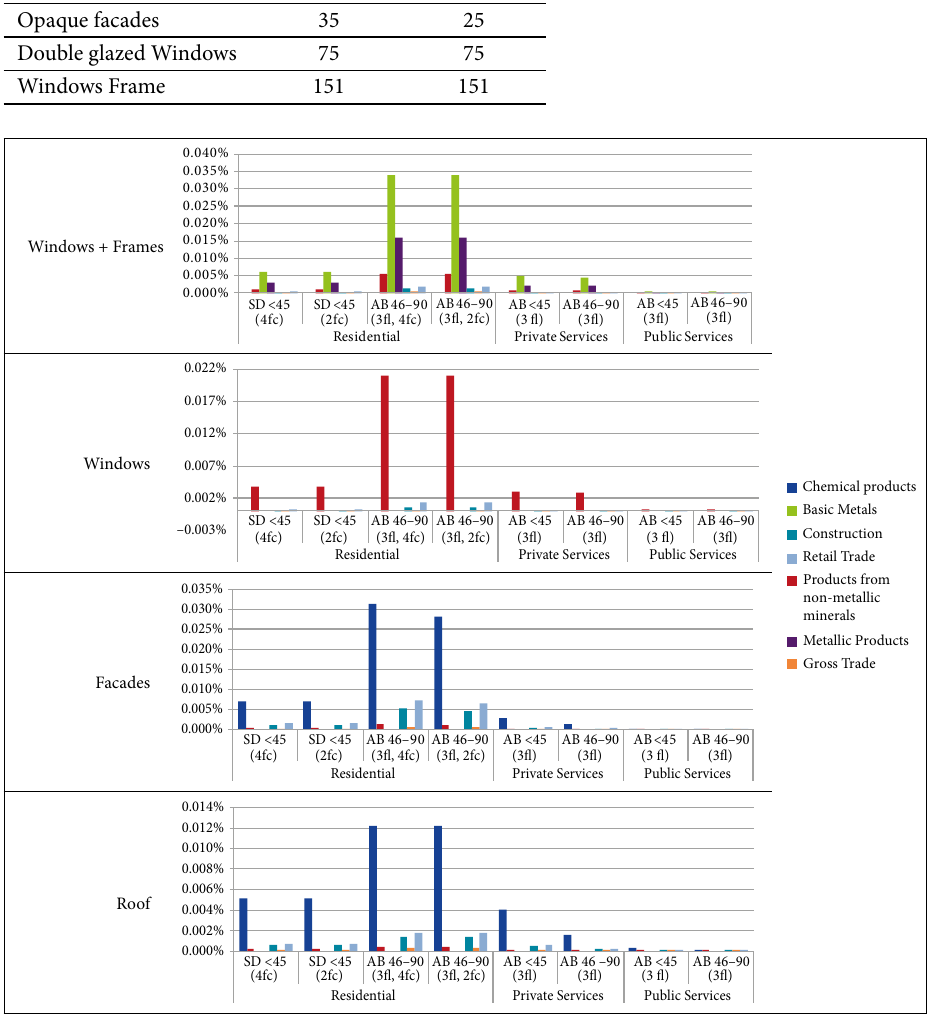
Table 1. Unit costs of each retrofit measure Retrofit measure cost (€/m 2 )